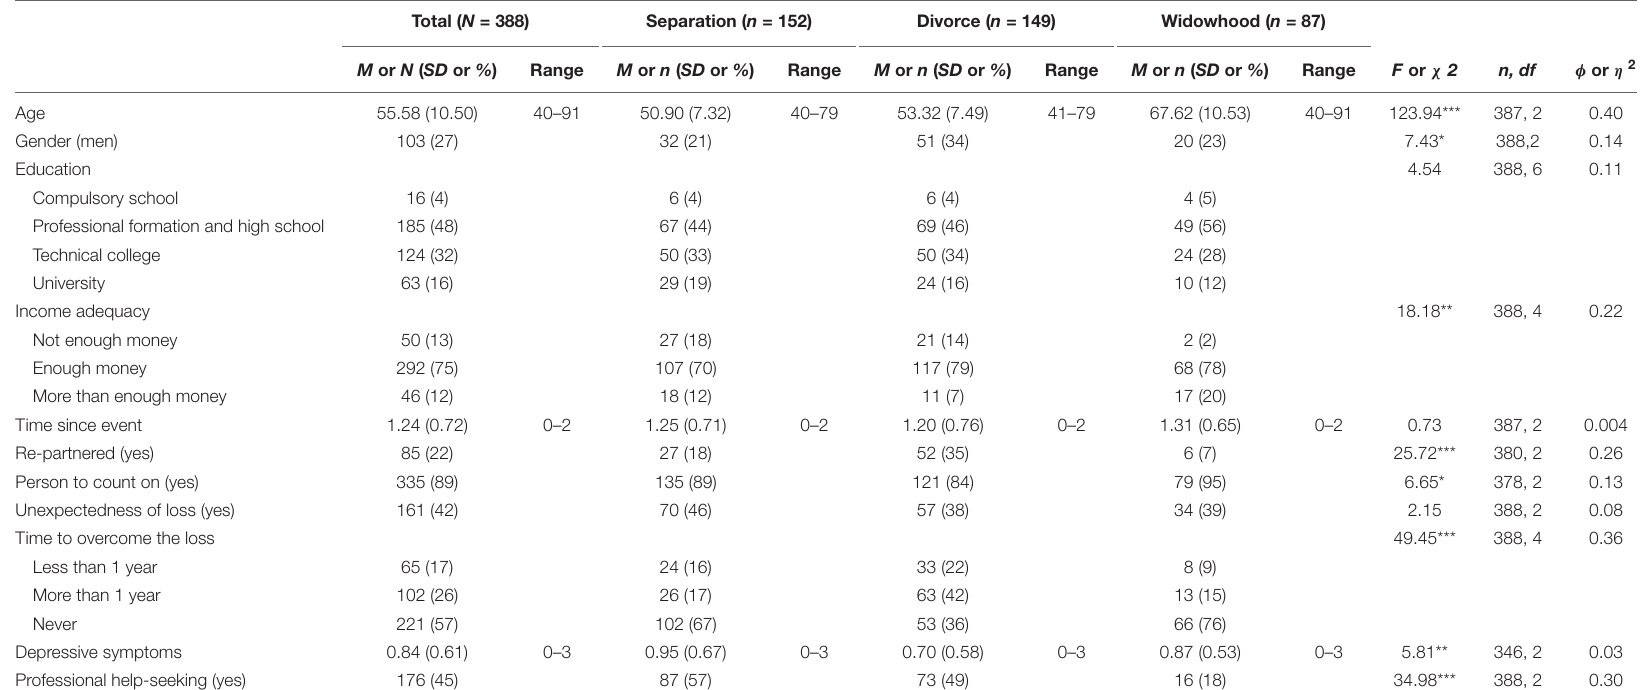
TABLE 1 | Person and event-related characteristics and professional help-seeking (PHS) of the total sample and by the critical marital